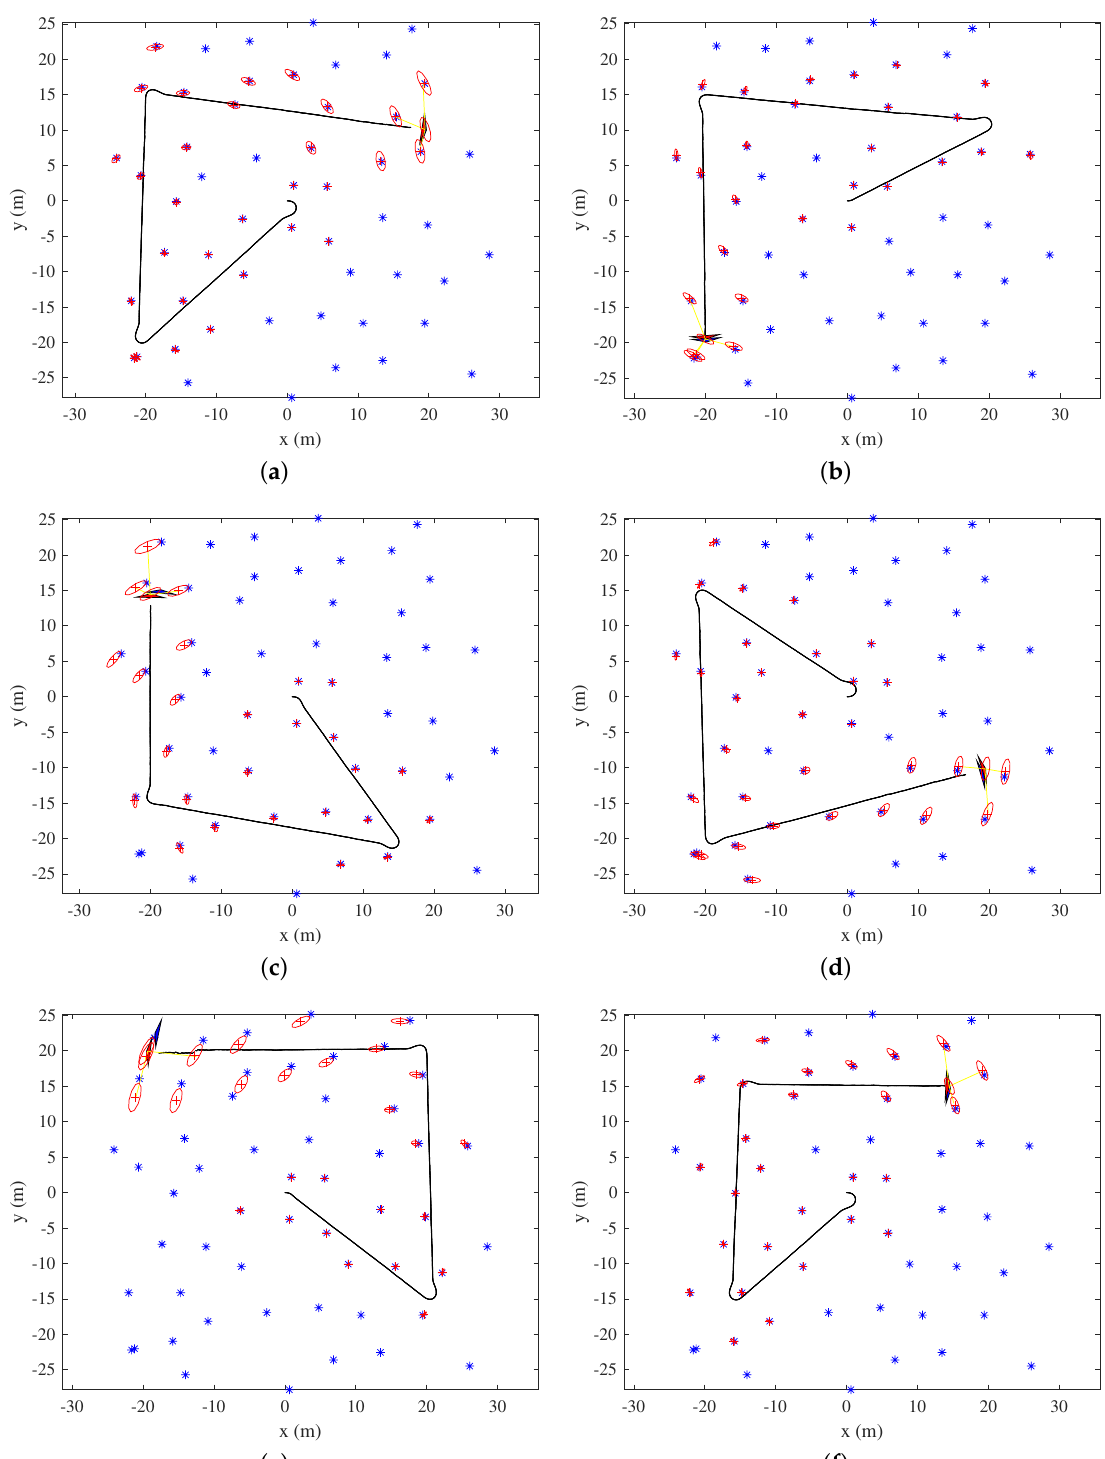
Figure 12. Examples of EKF-SLAM robot/landmark state when revisiting commenced: ( a – f ) The EKF-SLAM state used for simulations. After traveling through three positions, uncertainty has increased. Ten simulations for each SLAM state were performed using Covariance TSP fixed and Covariance TSP,